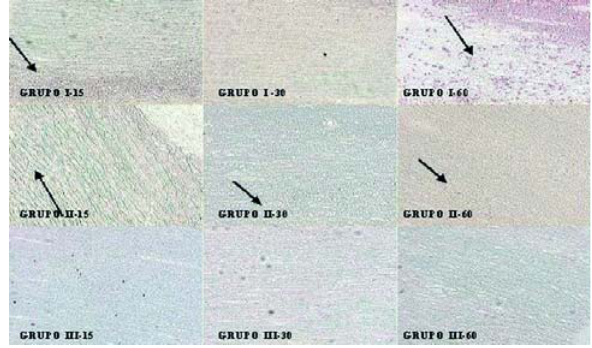
Fig. 5 - Fotomicrografias de condutos aórticos dos três grupos estudados, nos determinados tempos de observação (alizarina 100X). No grupo I, observa-se progressão da calcificação com o passar do tempo (cristais de oxalato de cálcio). No grupo II, observa-se calcificação fina, sem alterar a integridade da matriz extracelular. No grupo III, há ausência total de calcificação em todos os períodos